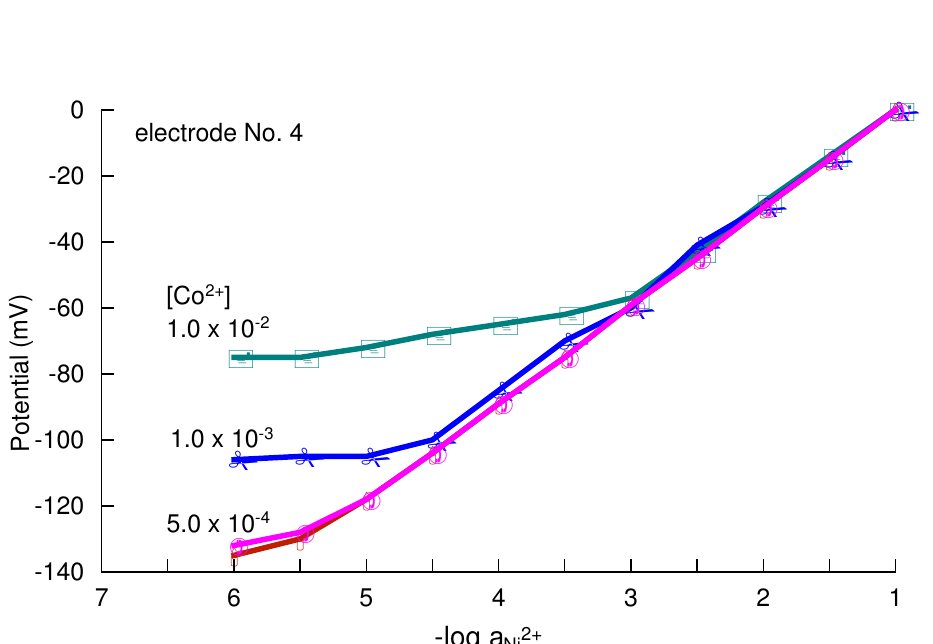
Figure. 5 : Variation of cell potential with Ni 2+ concentration at different concentration levels of Co 2+ ions (electrode no. 4).